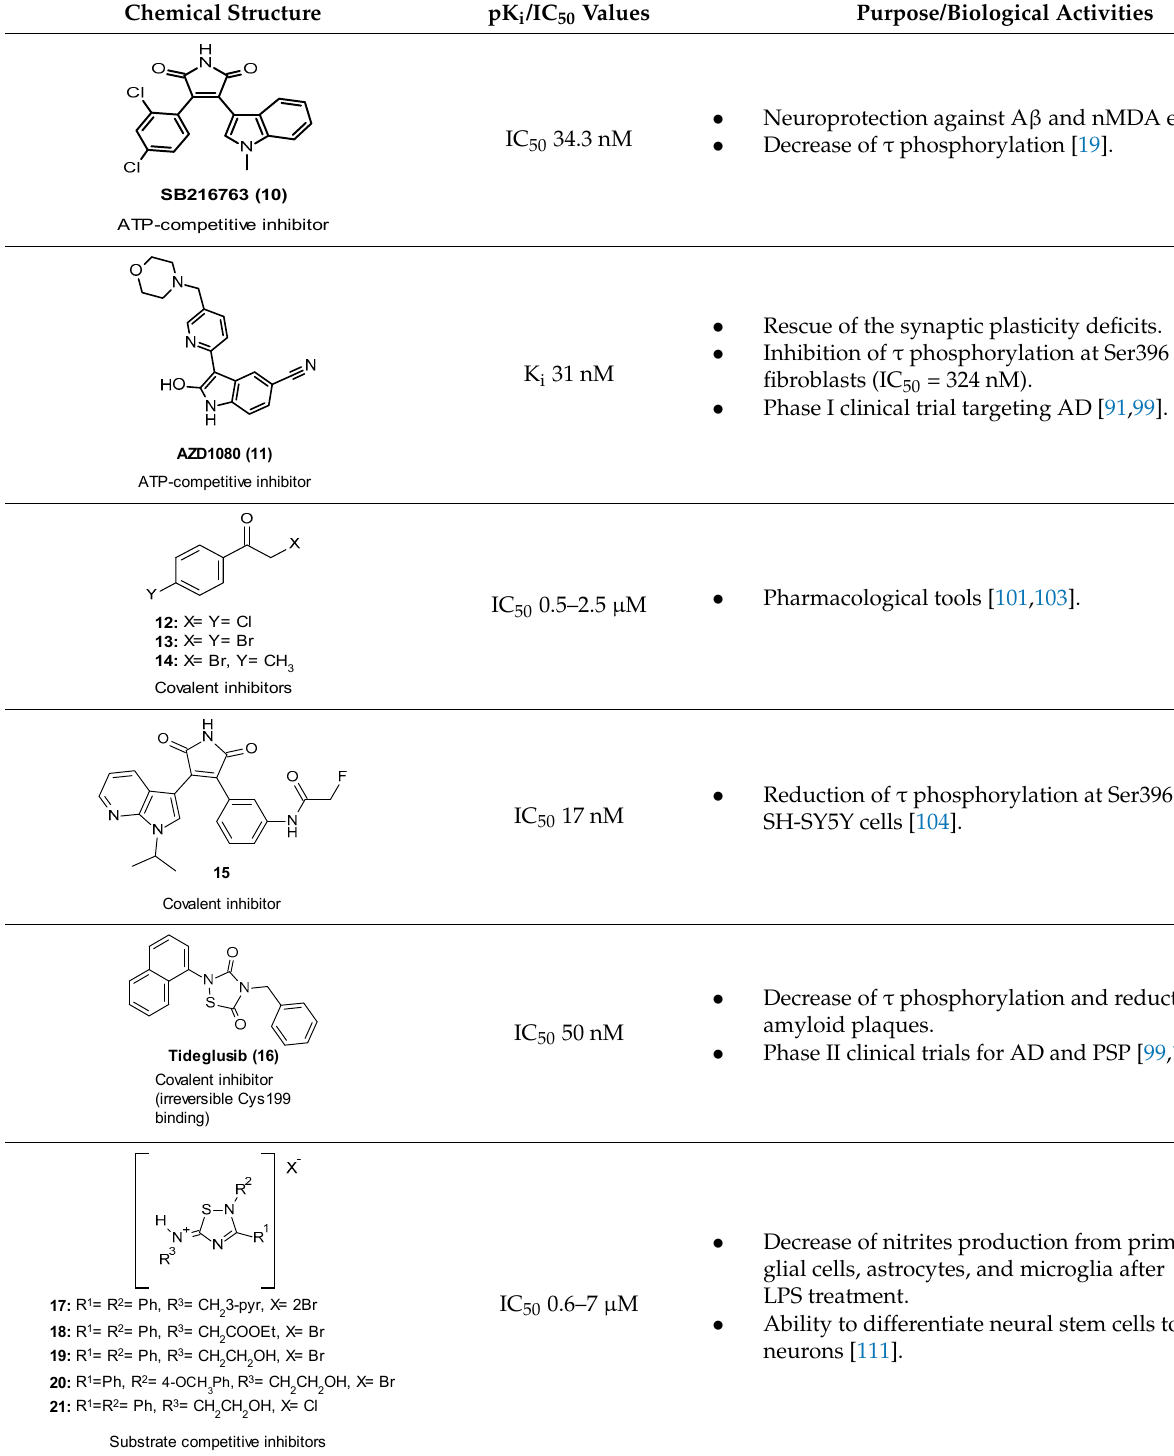
Table 1. GSK-3 β inhibitors and their applications.